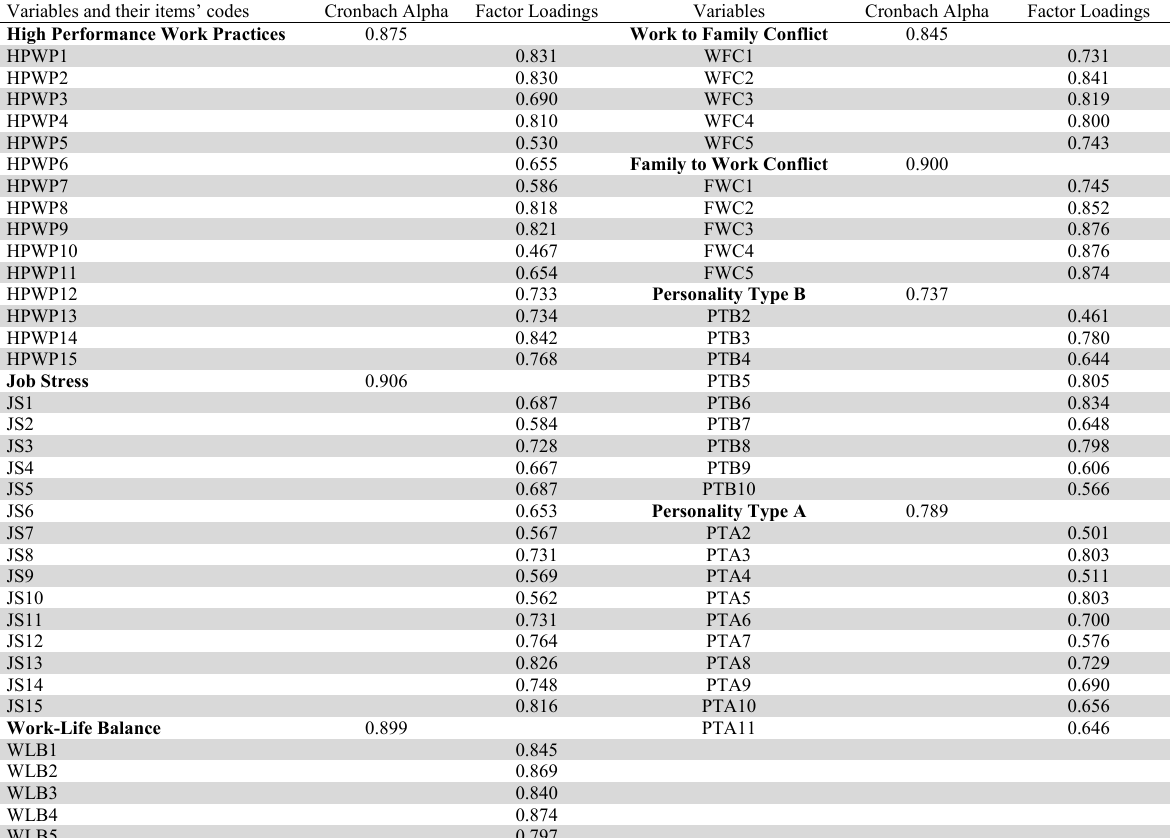
Reliability and factor analysis of constructs